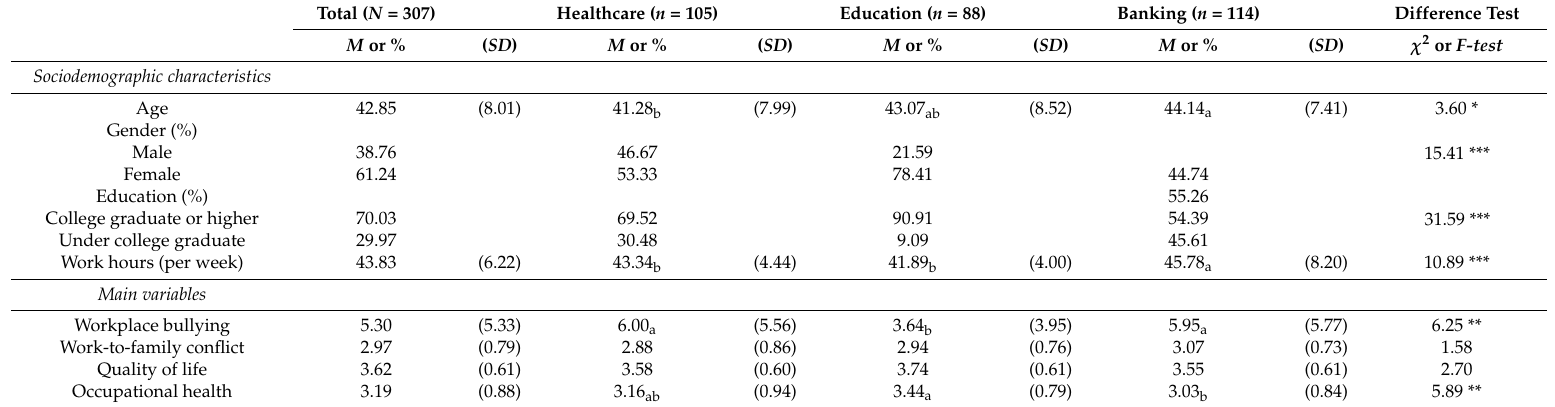
Table 1. Descriptive statistics of variables by